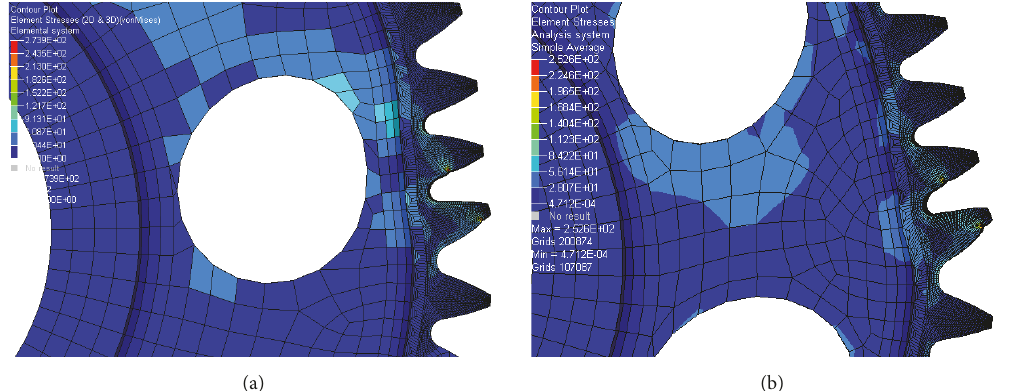
Figure 3: Example of stress distribution and static deformation of the gear with 8 holes in two angular configurations of the gear pair: loaded teeth are close (a) and far away (b) from a hole in the blank.